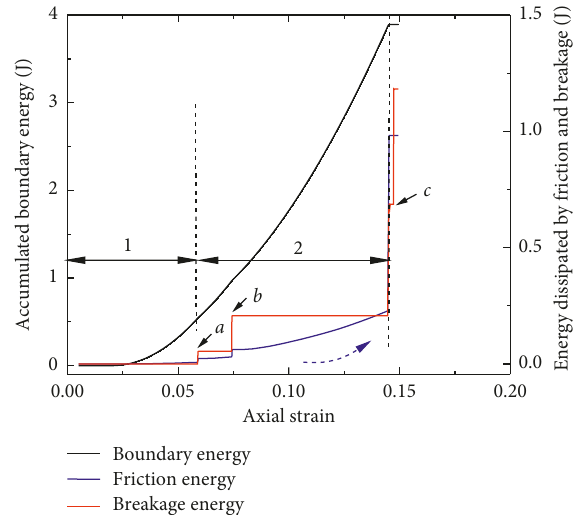
Figure 4: Evolution of boundary energy and energy dissipation for a single particle during